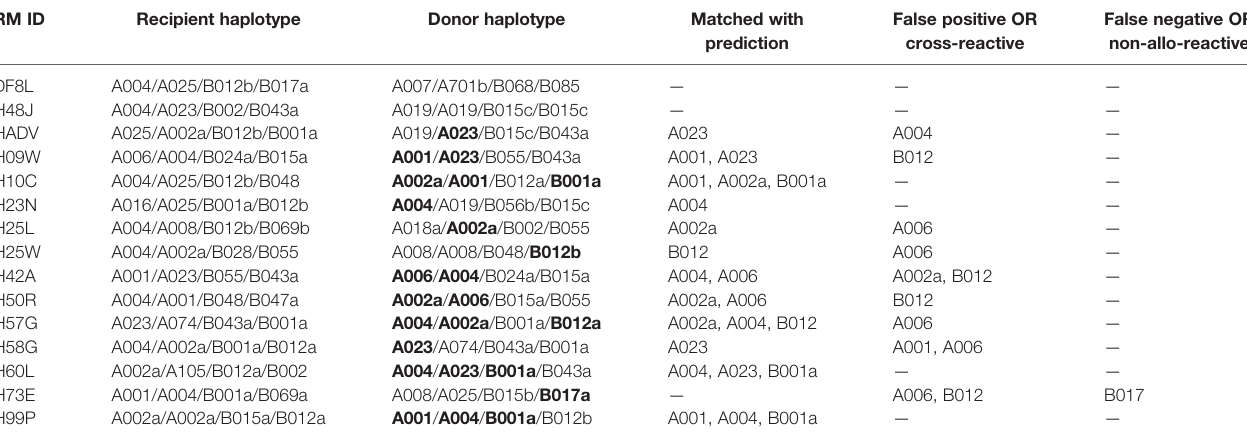
TABLE 1 | Mamu haplotypes of recipient and donor RMs and reporter cell line detection results. RM